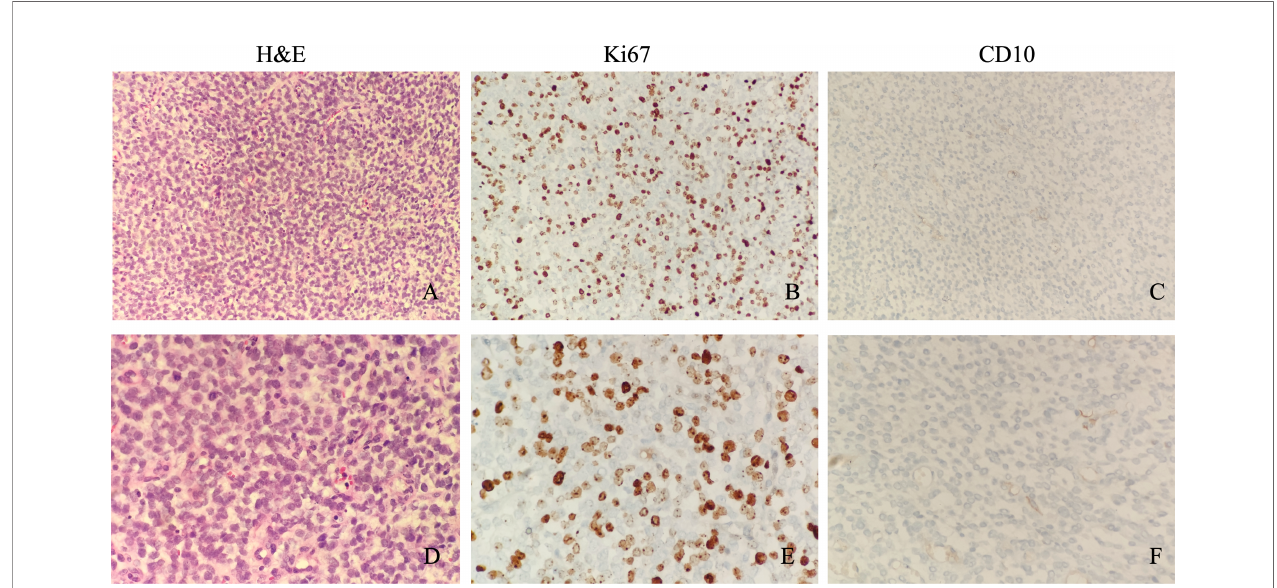
FIGURE 1 | Microscopic appearance of sarcomas with YWHAE-NUTM2B. Microscopically, these tumor cells are made of small round cells, with scanty eosinophilic cytoplasm and a hyperchromatic nucleus ( A , ×200 magni fi cation; D , ×400 magni fi cation). Immunostaining of Ki67 shows a high proliferative index ( B , ×200 magni fi cation; E , ×400 magni fi cation). CD10 was only positive in a small focus of tumor cells ( C , ×200 magni fi cation; F , ×400 magni fi cation).